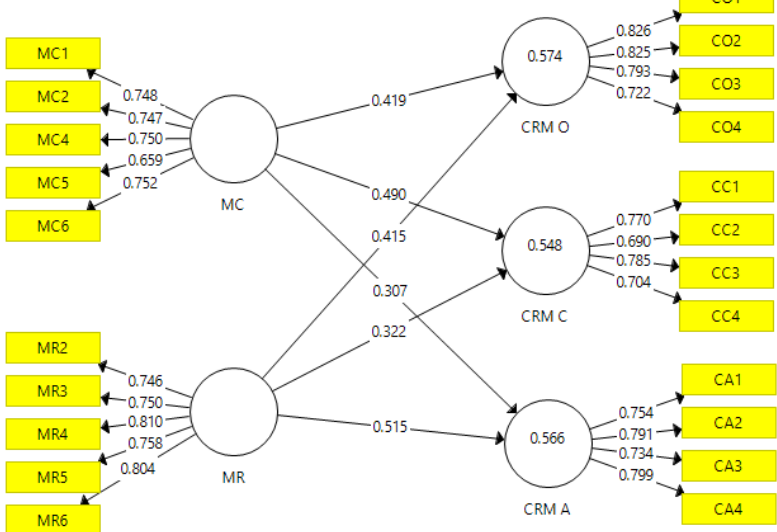
2 Fig. 2. Results for the hypothetized model with structural